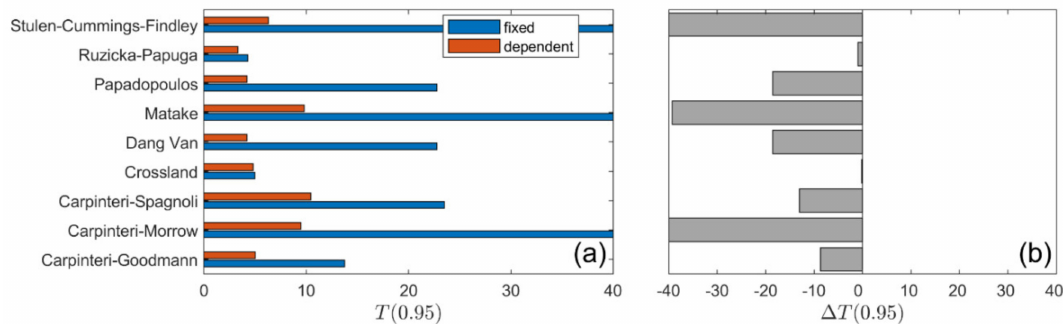
Figure 10. Summary comparison of calculation results for the analysed models under R = 0.0 for S355 steel: